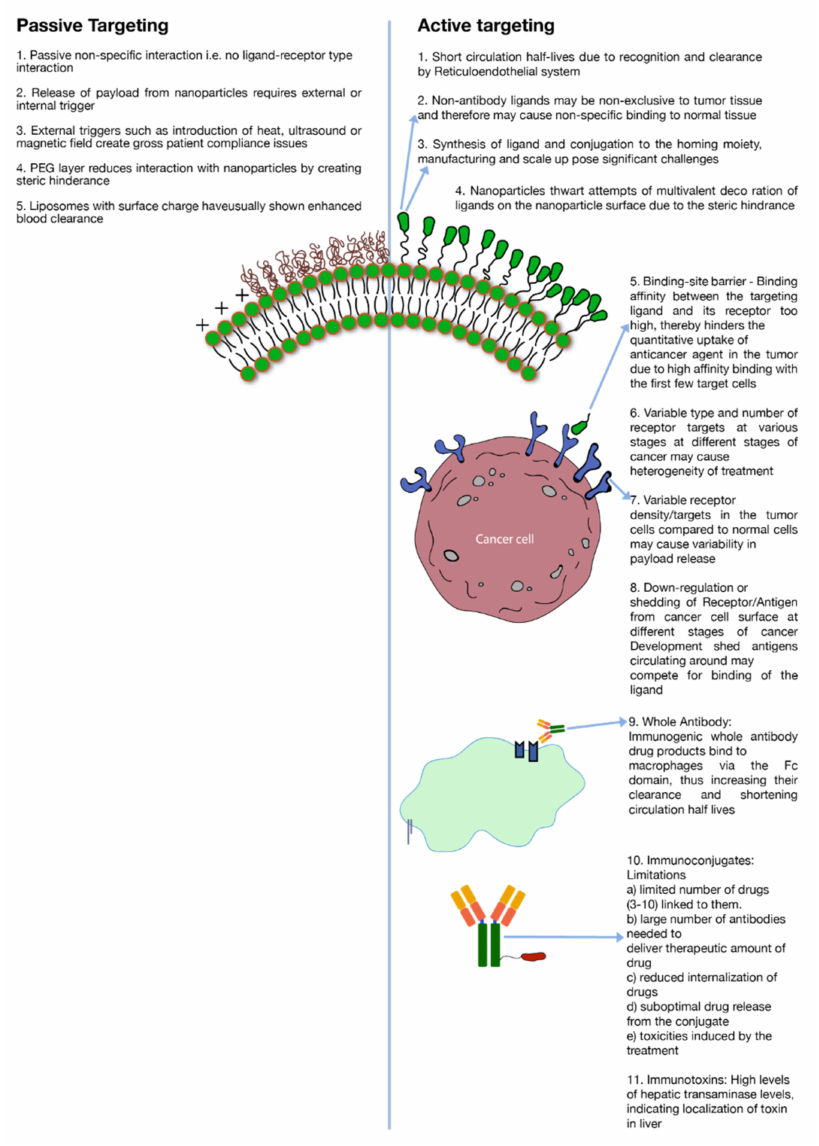
Figure 2. Limitations of active and passive